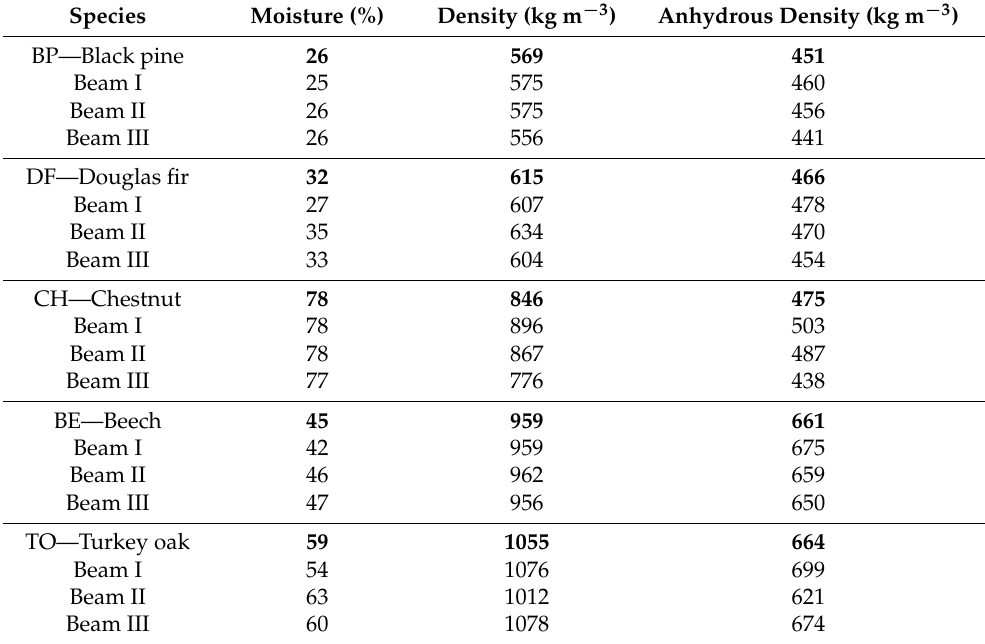
Table 2. Specifics of the wood beams used in the study. Numbers in bold represent values per species.